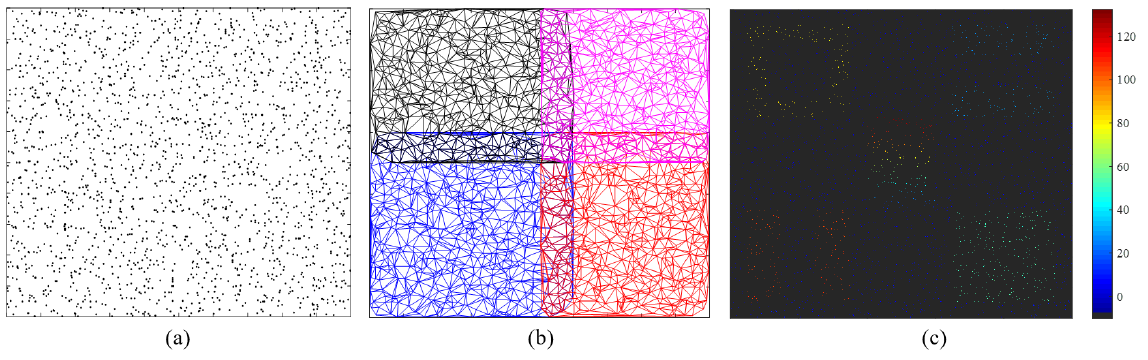
Figure 4. The simulated results of the BBN method: ( a ) selected PSs; ( b ) the networks of sub-blocks; ( c ) estimated elevations of